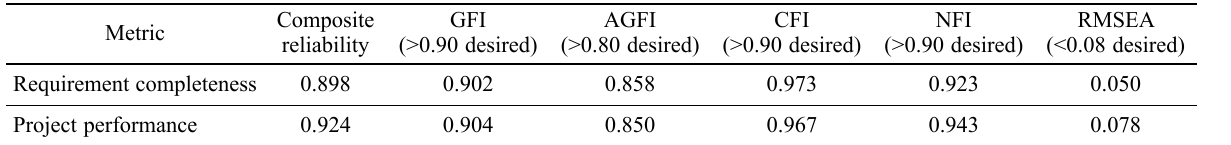
Table 4. Properties of the main constructs